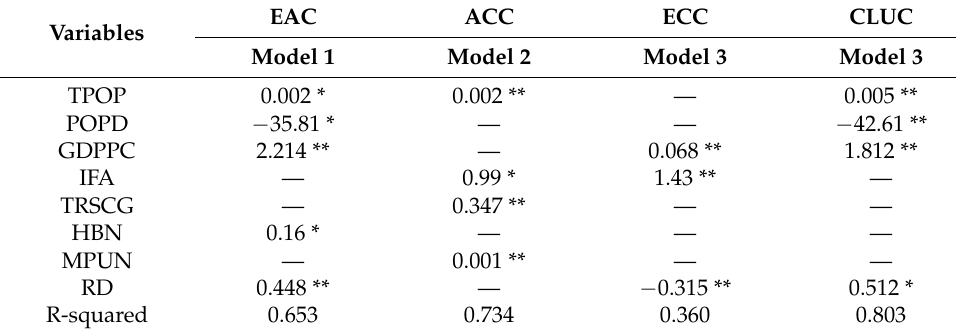
Table 8. Standardized regression coefficients and coefficients of determination (R 2